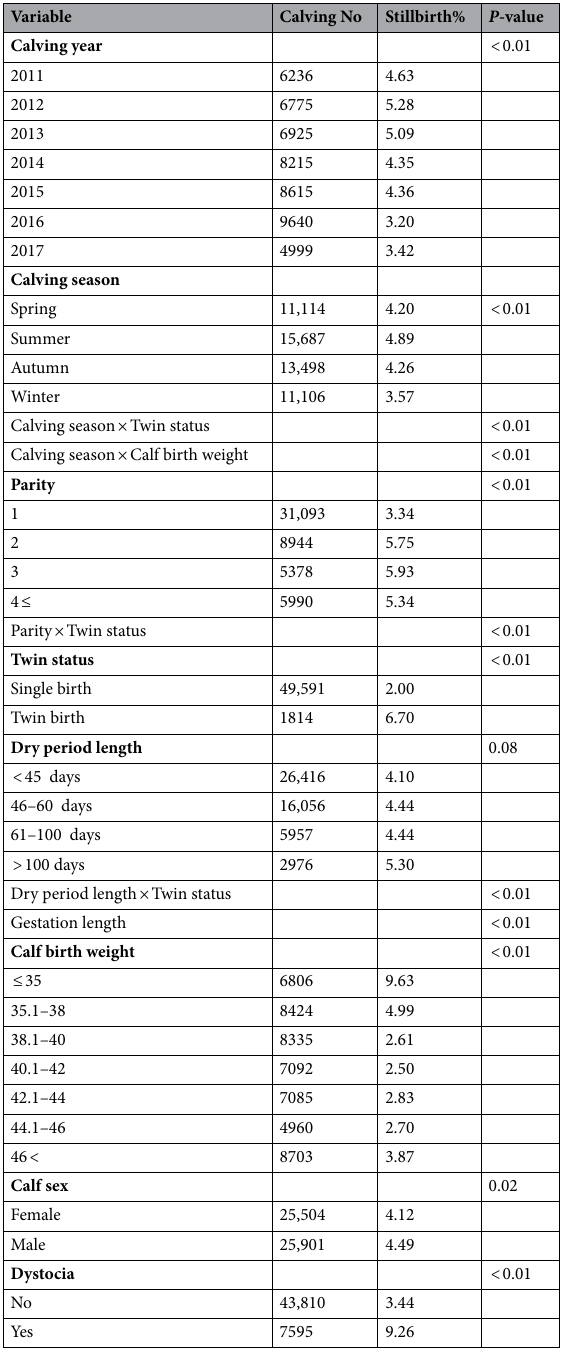
Table 5. Calving number and percentage of stillbirths for variables included in the binary logistic regression model of the generalized linear mixed model for cow-level risk factors for stillbirth incidence in Holstein dairy cows (n =